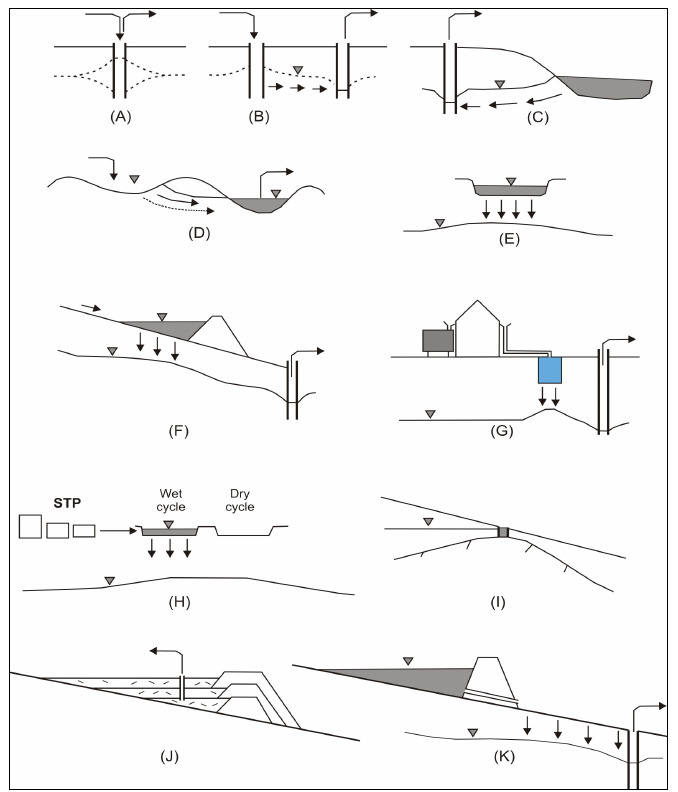
Figure 1. Different types of aquifer recharge [8] (with